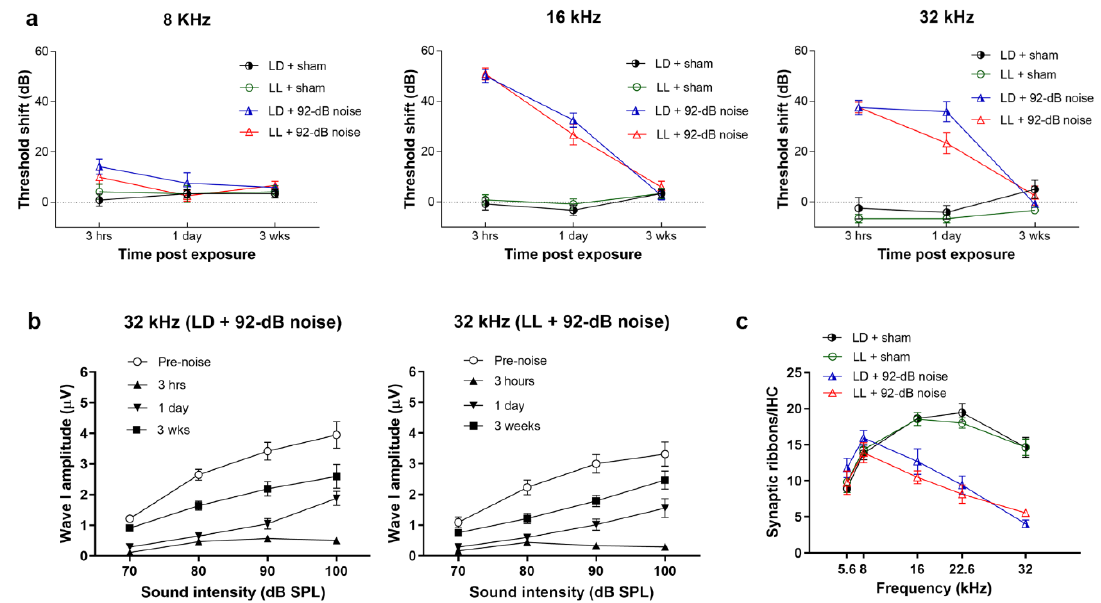
Figure 4. The ABR threshold shifts, wave I amplitudes, and synaptic ribbon counts in the LD and LL groups after 92 dB noise exposure. ( a ) No significant differences in the threshold shifts were observed between the LD and LL groups at 8, 16, and 32 kHz after the 92 dB noise exposure. Data are mean ± SEM ( n = 6 for each group). ( b ) ABR wave I amplitudes at 32 kHz were mostly attenuated at 3 h after the 92 dB noise exposure and increased later both in the LD and LL groups. There were no differences in wave I amplitudes between LD + 92 dB and LL + 92 dB groups. ( c ) A decreased number of synaptic ribbons were found over 16, 22.6, and 32 kHz at 3 weeks after the 92 dB noise. No significant difference in synaptic ribbon counts was observed between the LD and LL groups postexposure. Data are mean ± SEM ( n = 5 for each group).